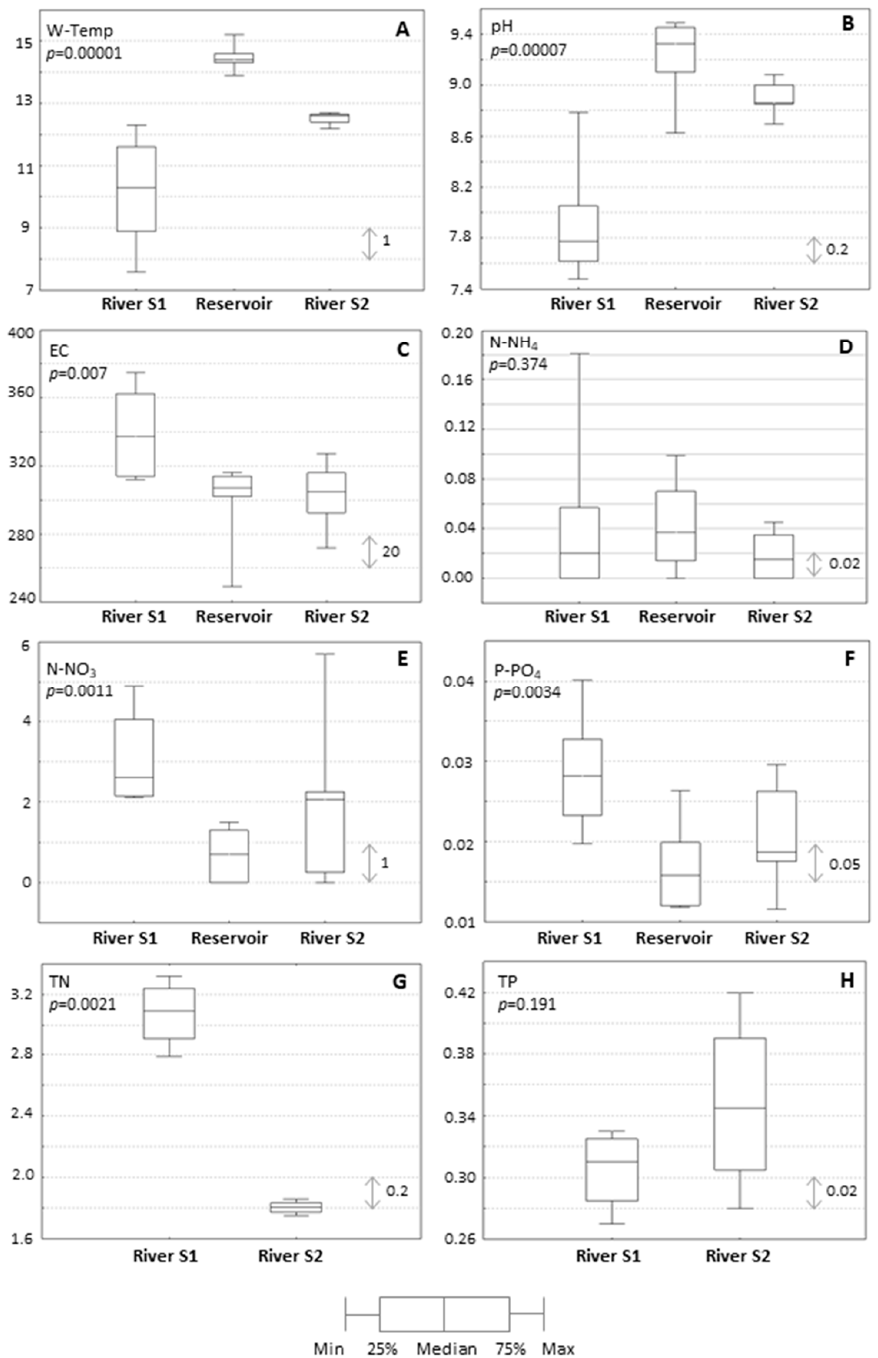
Figure 4. The hydrochemical parameters of the Moszczenica river and Stryków reservoir; graphs express diurnal measurements preceding the formation of heavy bloom; ( A ): water temperature [°C], p < 0.05; ( B ): water pH, p < 0.05; ( C ): electric conductivity [ μ S/cm], p < 0.05; ( D ): ammonium [mg/L], p > 0.05; ( E ): nitrates [mg/L], p < 0.05; ( F ): ortophosphates [mg/L], p < 0.05; ( G ): total nitrogen [mg/L], p < 0.05; ( H ): total phosphorus [mg/L], p > 0.05.